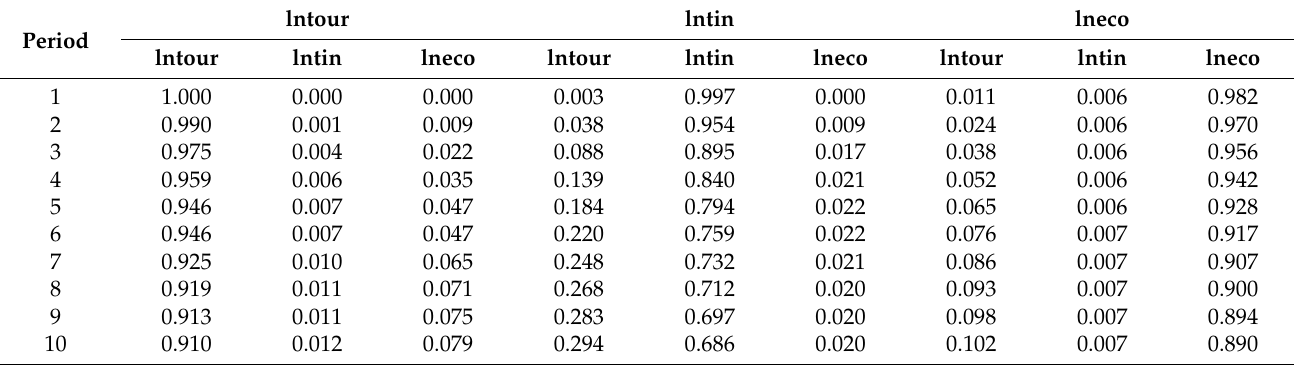
Table 9. Variance decomposition results.